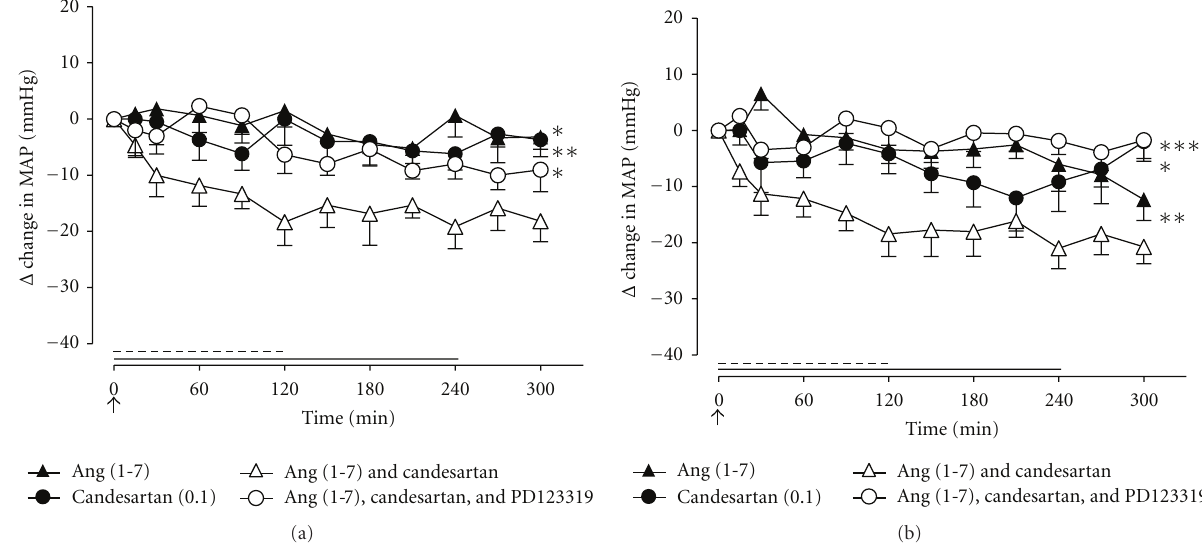
Figure 2: E ff ect of Ang (1-7) (15pmol/kg/min; 4-hour infusion depicted by full line), AT 1 R antagonist, candesartan (0.1 mg/kg bolus IV; depicted by an arrow), Ang (1-7) + candesartan, and Ang (1-7) + candesartan + AT 2 R antagonist, PD123319 (50 µ g/kg/min for 2 hours; depicted by dashed line), on MAP in (a) adult WKY rats ( n = 6) and (b) aged WKY rats ( n = 7). Values represent mean ± SEM. ∗ P < 0 . 05; ∗∗ P < 0 . 01; ∗∗∗ P < 0 . 001, for treatment e ff ect of Ang (1-7) + candesartan versus all other treatments as indicated (2-way RM